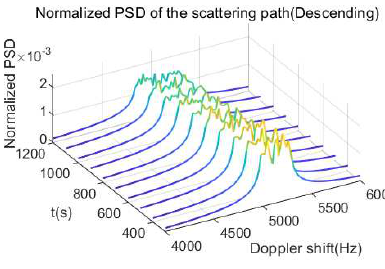
Figure 11. The normalized Doppler PSD